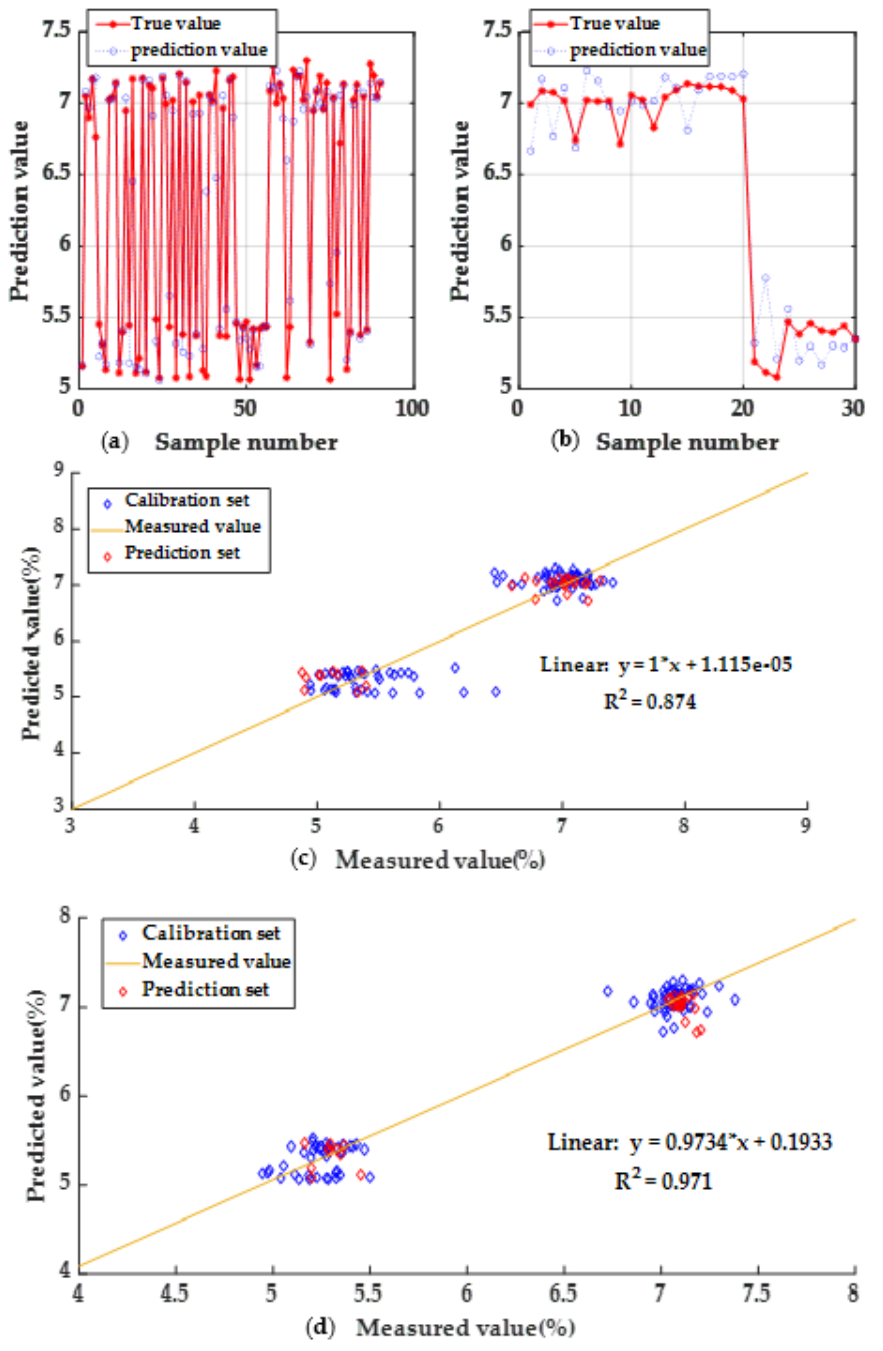
Figure 7. ( a ) Calibration set of (CARS + RF)-SPA-SVR model; ( b ) Prediction set of (CARS + RF)-SPA- SVR model; ( c ) (CARS + RF)-SPA-ELM model; ( d ) (CARS + RF)-SPA-BPNN model.